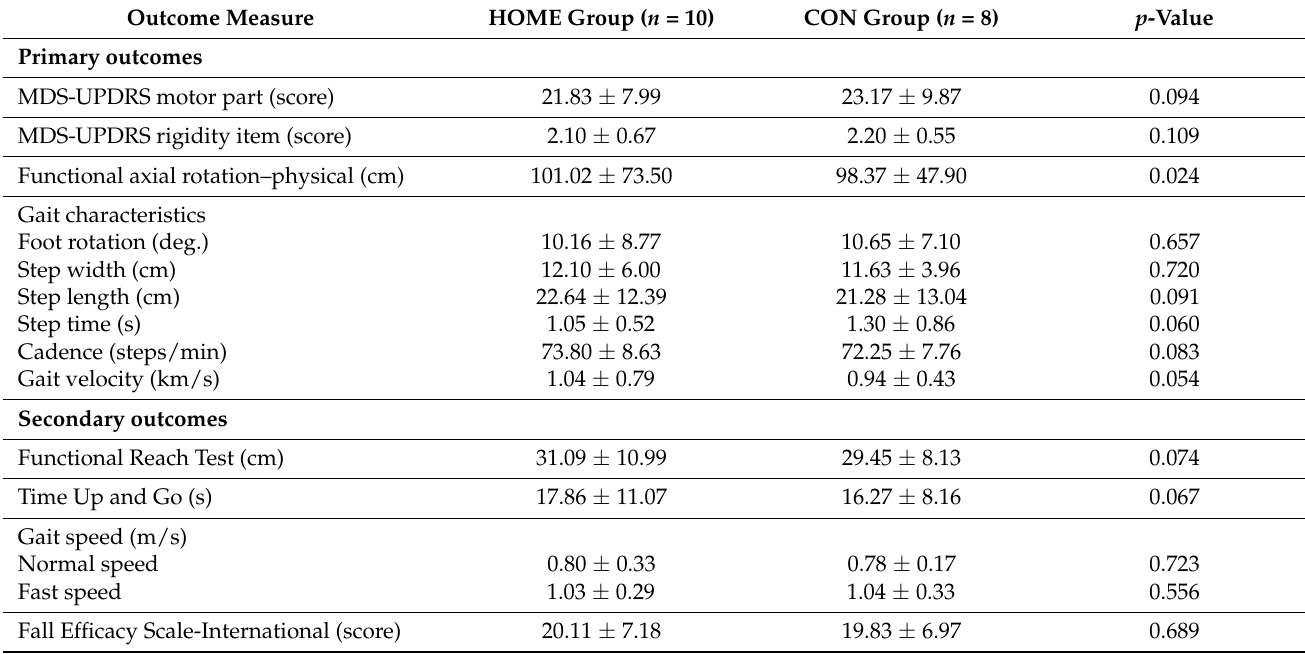
Table 2. Baseline comparison of primary and secondary outcomes between groups. Values are mean ± standard